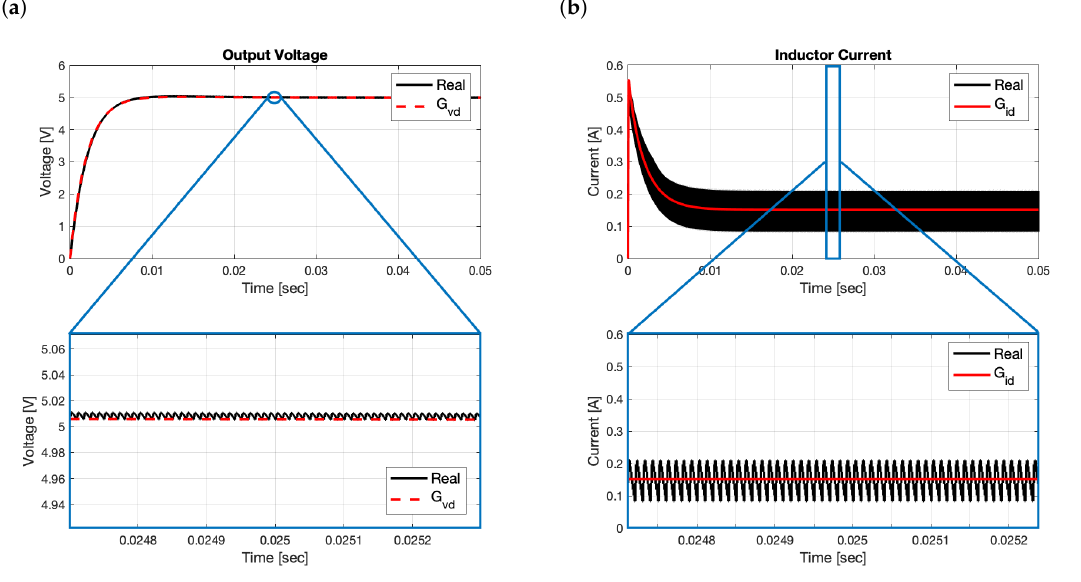
Figure 12. Validation of the output voltage ( a ) and current ( b ) transfer functions.